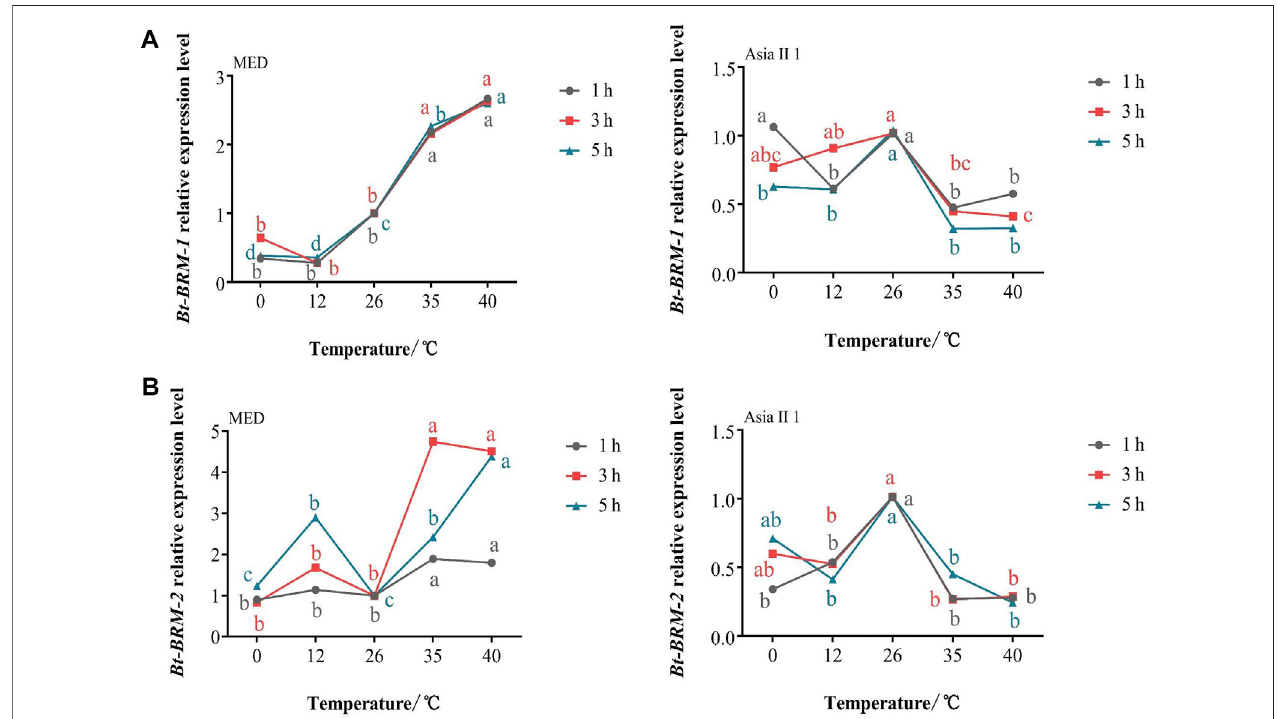
FIGURE 5 | Variation trend of relative expression levels of Bt-BRM-1 (A) and Bt-BRM-2 (B) in MED and Asia II 1 after exposure to different temperatures. Different lowercase letters indicate signi fi cant difference at p < 0.05.